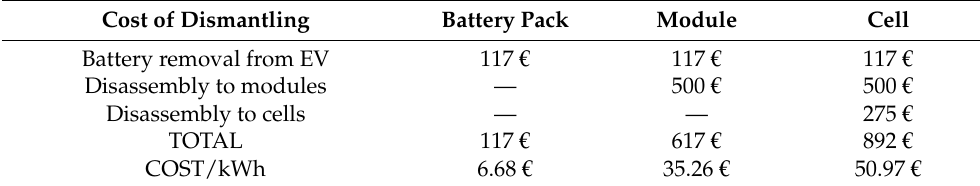
Table 2. Cost of disassembling battery packs. Reprinted from Ref.